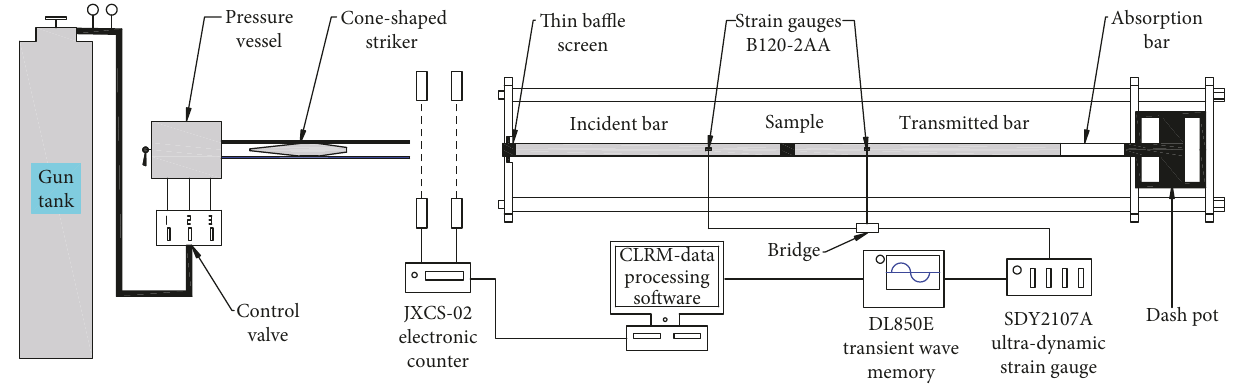
Figure 3: The SHPB test system.